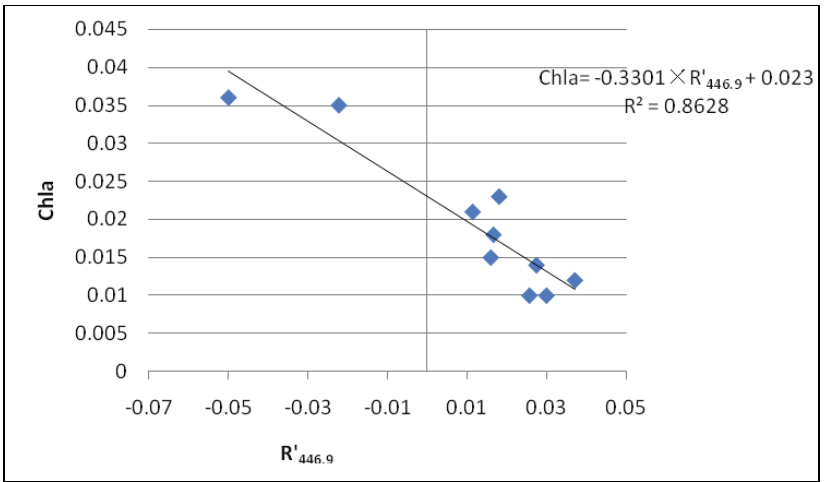
Figure 9. Scatter plots of Chl- a versus first-derivative of reflectance at 446.9 nm.